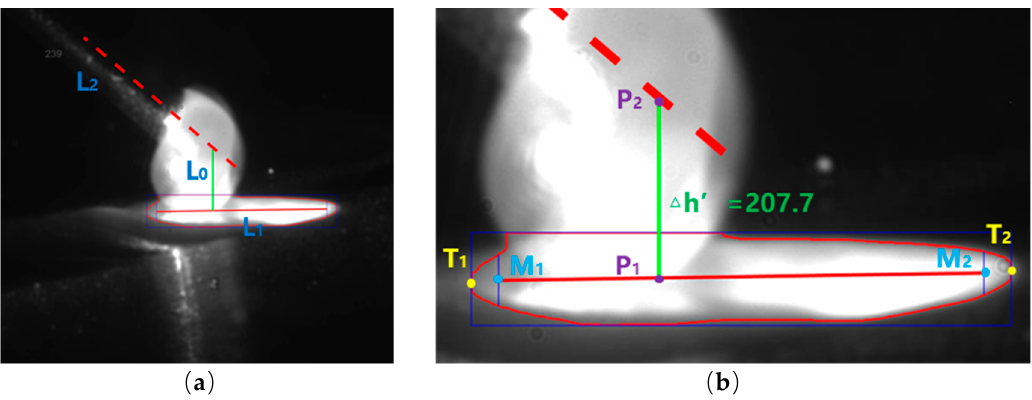
Figure 6. ( a ) Advance calibration of L 0 and L 2 ; ( b ) calculation of droplet transfer distance in pixels.